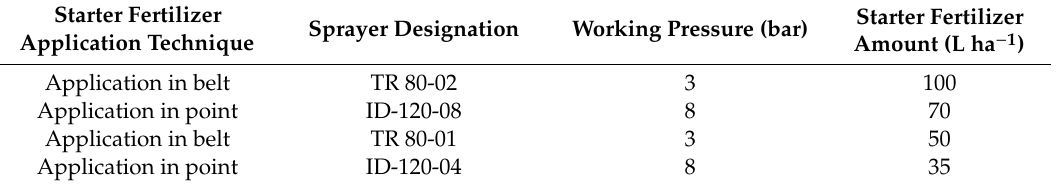
Table 4. Treatments, amounts and techniques of application of applied fertilizers.